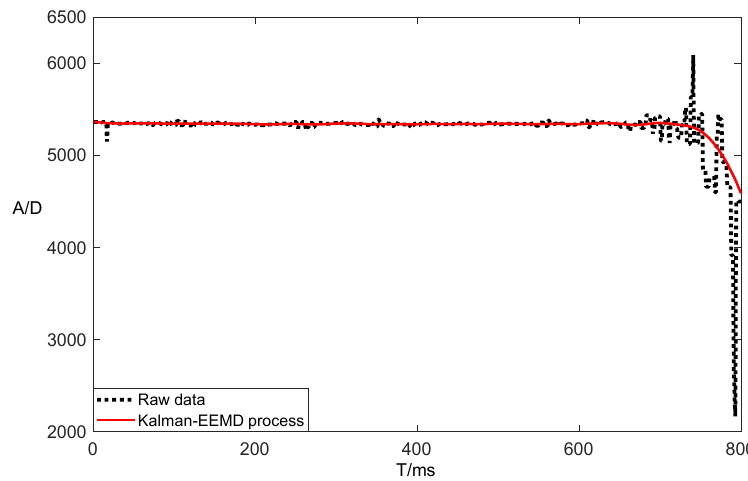
Figure 17. The rendering of the Kalman-EEMD filter. A polynomial fit was used to fit the raw data, and the fitting results are shown in Figure 18, with the red line representing the raw data and the black line the fitted data. The third-order fit and fifth-order fit in the figure are poor, and the fit graph appears to overshoot after exceeding the ninth-order. Through experimentation, the ninth-order fit was found to be the best. The results were compared with the Kalman-EEMD filtering effect, and the results are shown in Figure 19.